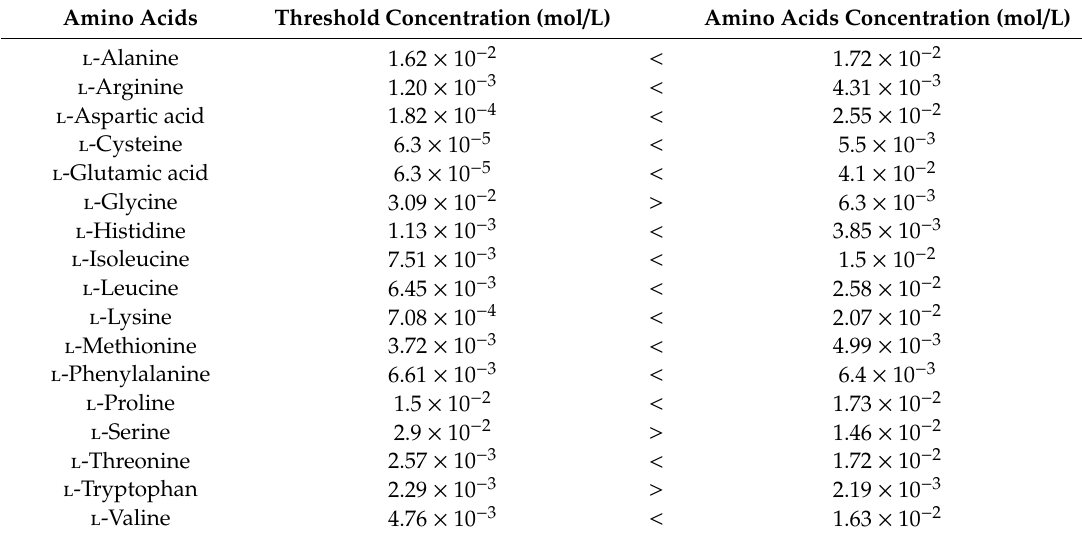
Table 1. Comparison between threshold concentrations and higher levels of l -amino acids concentrations in 22 g of e ff ervescent powder dissolved in a volume of 200 mL of water. This powder is a unique complex of amino acids from pure protein sources, whey protein, and calcium caseinates (Nutritional Technologies International, Optizone ™